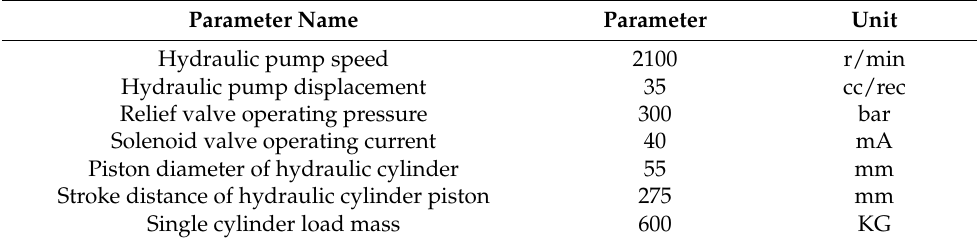
Table 3. System modelling-related parameter settings.